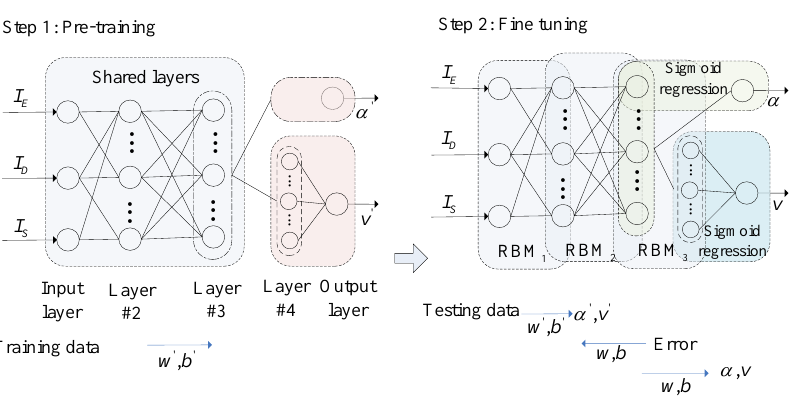
Figure 3. Improved MSR-DBN prediction